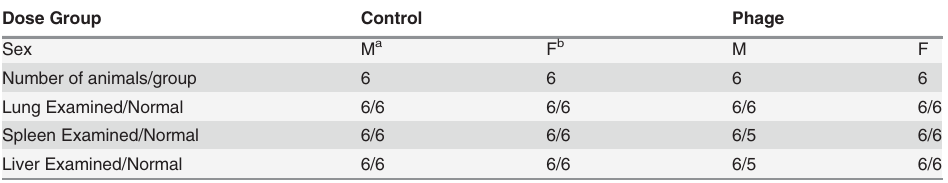
Table 3. Incidence of histomorphological observations.